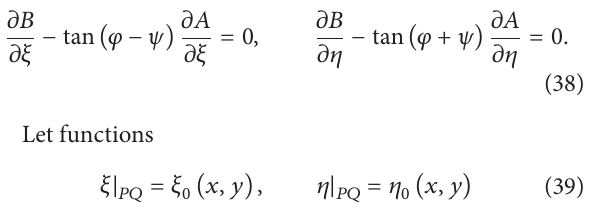
Figure 1: The Cauchy